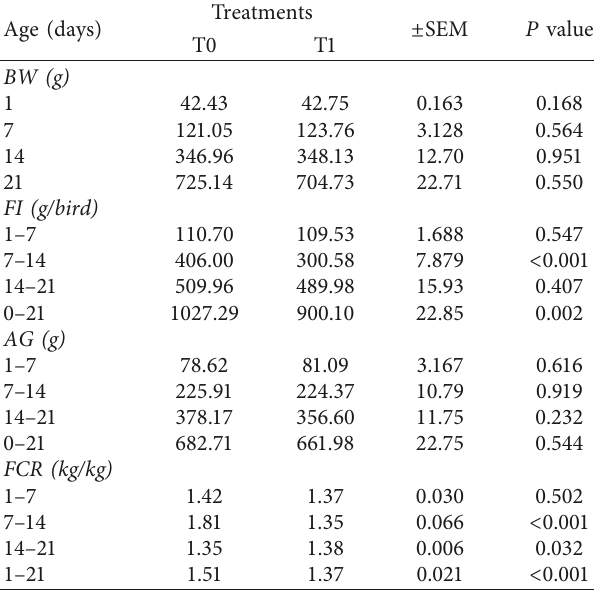
Table 2: Effect of the mixed powder of leaves of plants with medicinal properties on growth performance in broiler.